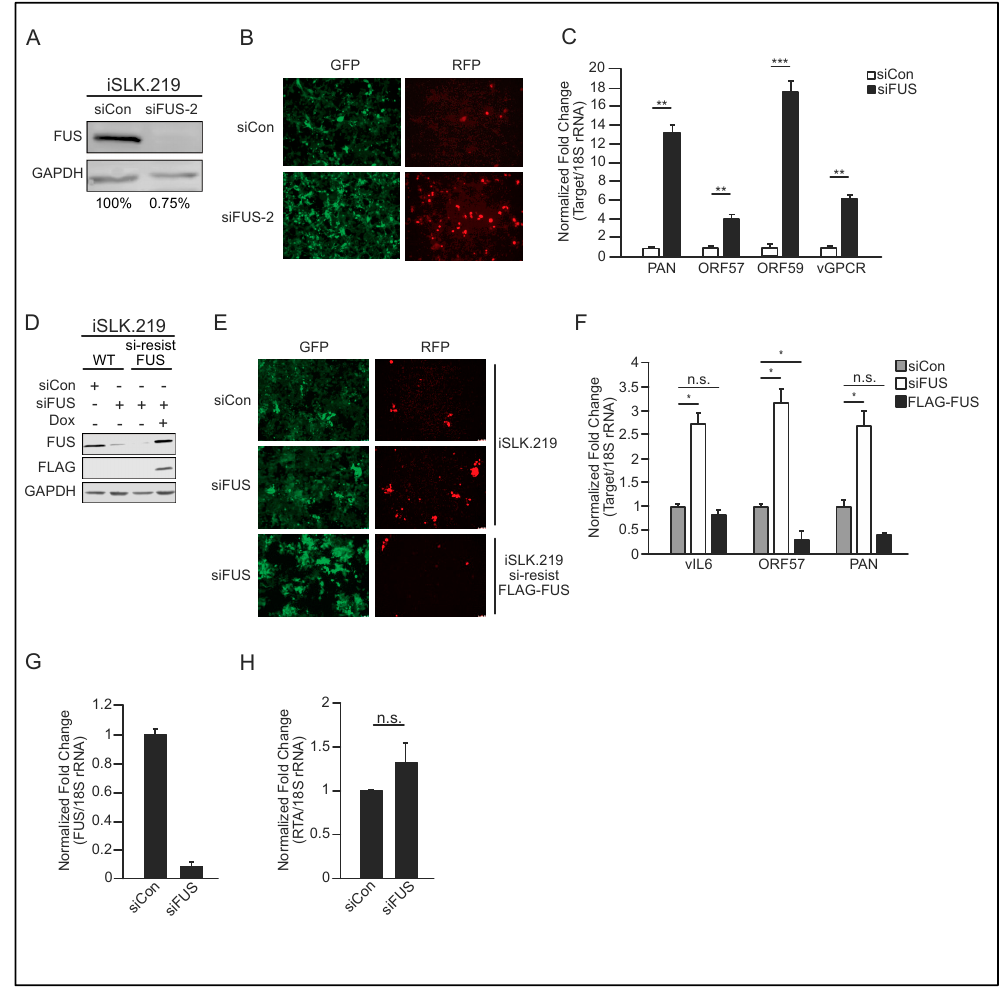
Figure 3. Independent verification of FUS-siRNA specificity. ( A ) iSLK.219 cells were depleted of FUS with a second FUS-siRNA and induced with doxycycline for 48 h. Knockdown efficiency was determined by western blot analysis and is indicated beneath each lane. ( B ) Fluorescent microscopy, at 10× magnification, of iSLK.219 cells depleted of FUS in ( A ). ( C ) Quantification of viral gene expression in cells described in ( A ) by RT-qPCR. All samples were normalized to 18S and siCon set to 1. ( D ) Western blot analyses of protein extracts from WT iSLK.219 and iSLK.219 cells transduced with siRNA-resistant FLAG-tagged FUS. Cells were treated with either control or FUS-siRNA and induced for 48 h with doxycycline. ( E ) Fluorescent microscopy, at 10× magnification, of cells in ( D ). ( F ) RT-qPCR of viral gene expression in cells described in ( D ). All samples were normalized to 18S and siCon set to 1. ( G ) Uninfected iSLK control cells, which harbor the doxycycline-inducible RTA, were depleted of FUS with siRNA for 48 h, followed by doxycycline treatment for 24 h. FUS knockdown was determined by RT-qPCR. ( H ) Quantification of RTA mRNA levels from cells in ( G ). Student t test used to determine statistical significance * p ≤ 0.05. ** p ≤ 0.005. *** p ≤ 0.0005, n.s. not significant.